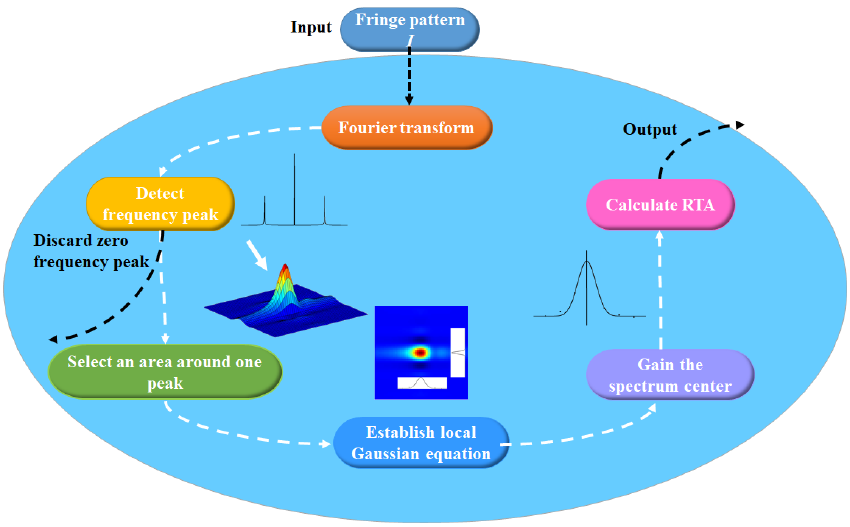
Figure 2. Flowchart for the robust RTA evaluation method.